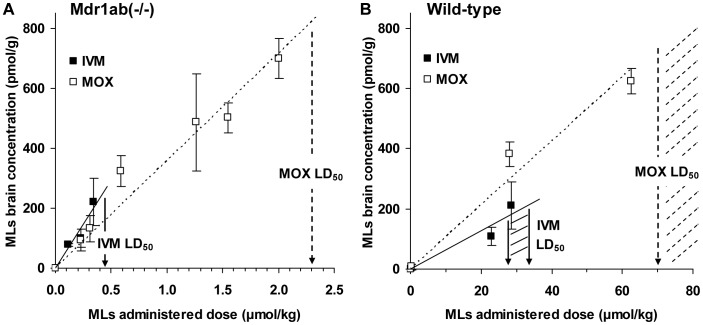
Absolute brain accumulation of MLs in Mdr1ab(−/−) and wild-type mice as a function of the administrated dose.IVM (filled squares) or MOX (empty squares) was administered to Mdr1ab(−/−) mice or to wild-type mice at increasing doses. Highest doses used for each ML were below the LD50 to ensure a non-lethal effect of the administration. Mice in each group were sacrificed 24 h after treatment and drug concentrations were determined in brain and plasma. Absolute brain accumulation was plotted against the administrated dose in (A) Mdr1ab(−/−) or (B) wild-type mice. A positive and significant linear correlation was observed between brain uptake and the administered dose rate (R2>0.94 in all cases). All measurements are expressed as mean ± S.D. of six animals.